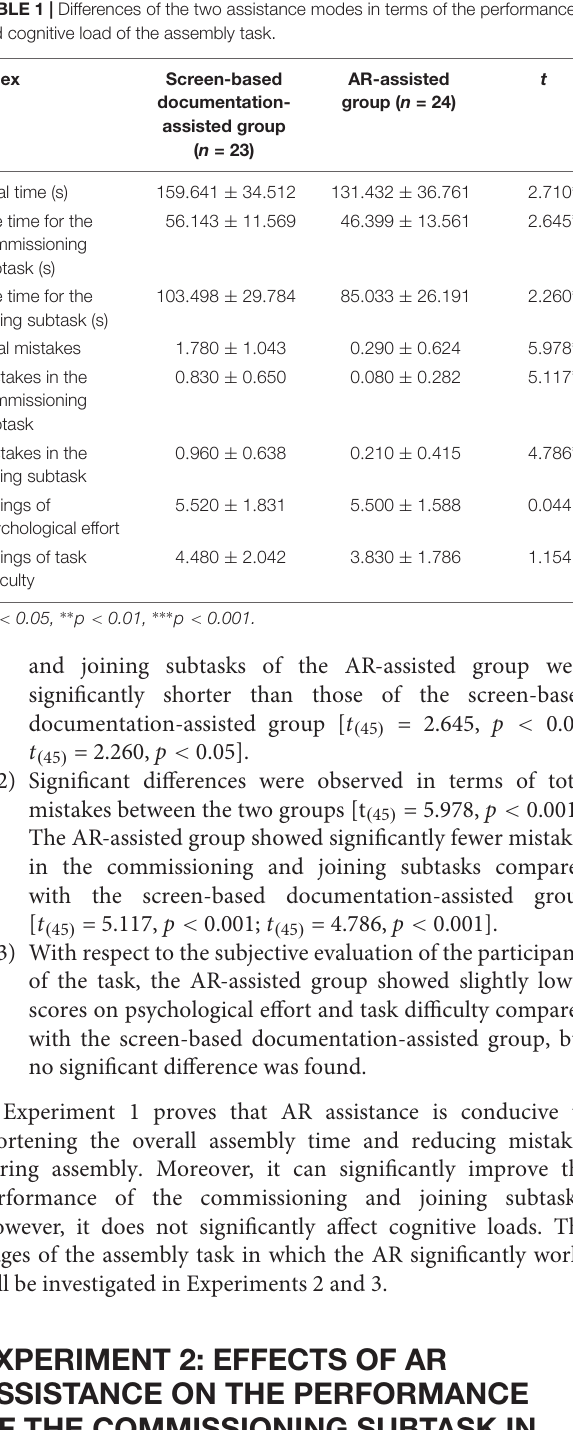
Frontiers in Psychology |